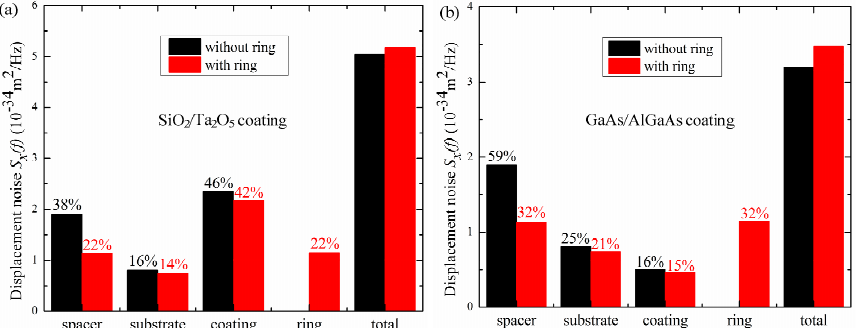
Figure 6. Contributions to the thermal noise of the optical length S x (f) of a cubic optical cavity with and without thermal expansion compensation rings. ( a ) ULE spacer, FS substrates, SiO 2 /Ta 2 O 5 coating, and ULE rings, the thickness d coa = 2 µ m cited from Refs. [17,43]. ( b ) ULE spacer, FS substrates, GaAs/AlGaAs crystalline coating, and ULE rings, the thickness d coa = 6.83 µ m cited from Ref. [21].